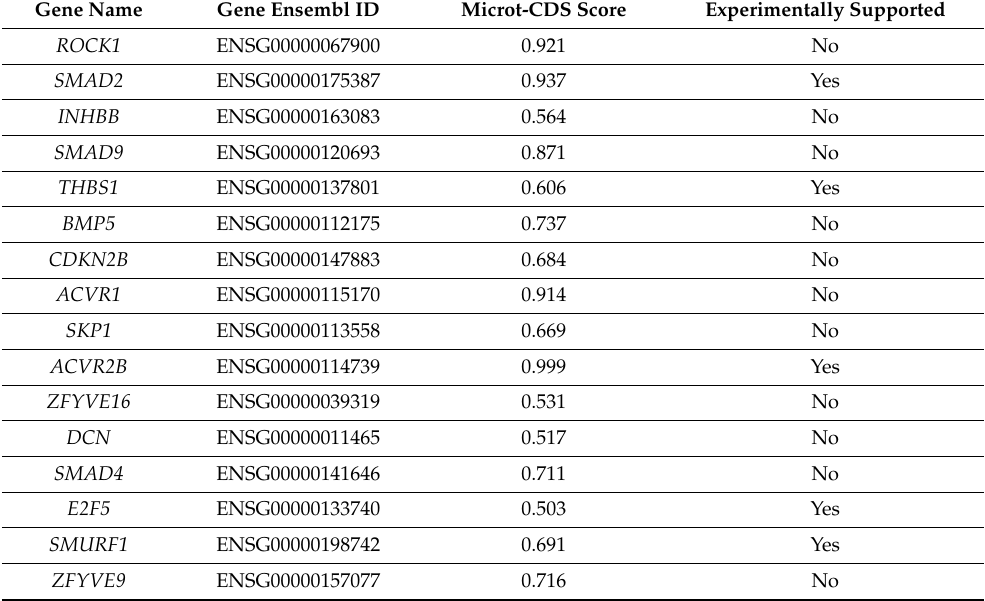
Figure 7. Bubble plot represents the top 10 significantly enriched KEGG pathways for miR-132-3p. The coloured scale bar indicates the − LOG (Q-value) where yellow indicates more significance and blue indicates less significance. Q-value is the FDR adjusted p -value. Bubble size represents the number of genes targeted in that particular pathway (gene count). The y -axis represents the pathway rank from most to least significant (1 through 10). The x -axis represents the number of miRNAs that are enriched in a particular pathway relative to the number of target genes that are enriched in the same pathway, known as the miR:gene ratio. Table 3. List of miR-132-3p target genes in the TGF β signalling pathway returned from DIANA miRPath v.3. MicroT-CDS score is the miRNA target prediction algorithm score where values closer to 1 are highly predicted. Experimental support refers to whether the predicted target has been supported by experimental evidence, such as Western blot or luciferase assay.